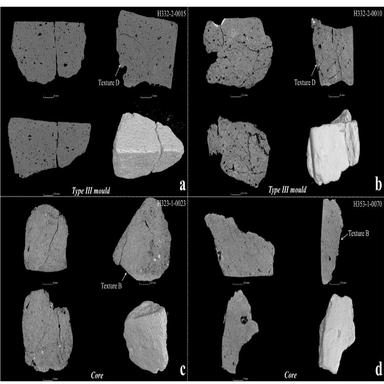
Three-view and 3D-reconstructed photographs of the Type III moulds and core samples obtained by the micro-CT scanning.